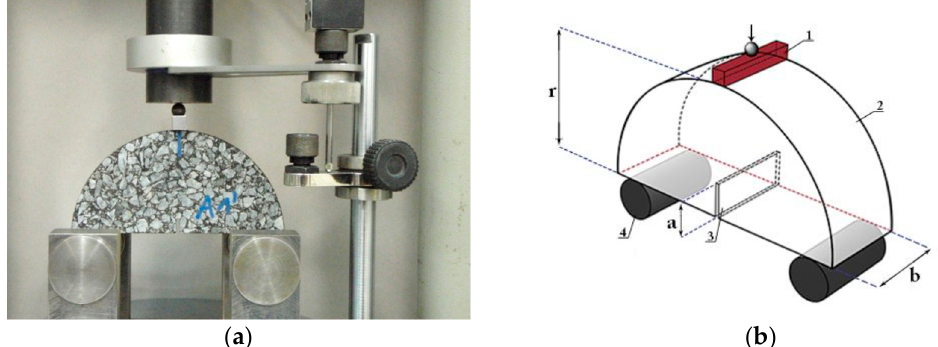
Figure 7. Semi-circular bending test (SCB) with the displacement strain rate setup: ( a ) photograph of the test setup. ( b ) Layout of the supports and loading point (1—loading rod, 2—sample, 3—notch, and 4—supporting rods).